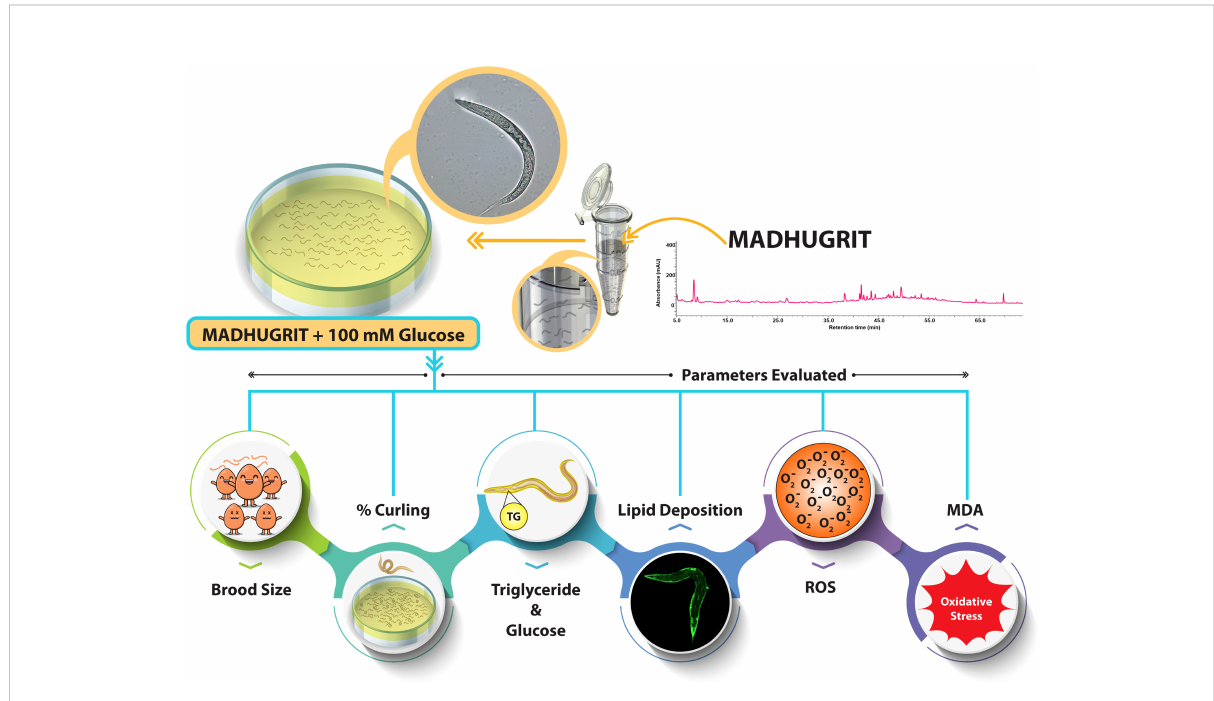
FIGURE 1 Schematic of C. elegans treatment and parameters